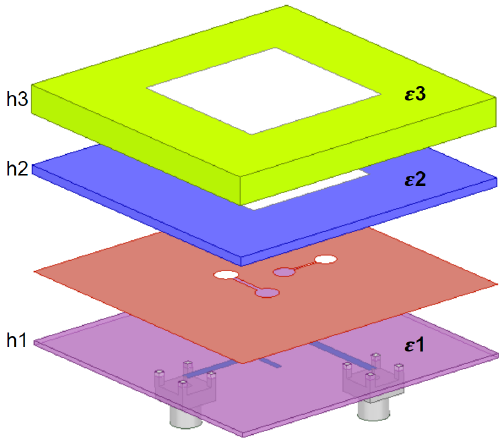
FIGURE 1: Expanded view of the antenna element The feeding mechanism used here is the aperture coupled feeding technique [15] and has many advantages over other patch antenna feeding techniques. These include reduction of spurious radiations from feed, independent choice of sub- strates for patch and feed, and increase in bandwidth by using thick substrate while having the least cross-polarization [16] [17]. The two dumbbell-shaped apertures are arranged in T- shape to increase isolation between them. Dimensions and dumbbell shape of the aperture are chosen to obtain the re- quired uniform coupling and cross-polarization suppression. The two feed lines corresponding to H and V polarization aperture are optimized to achieve the required isolation and matching.